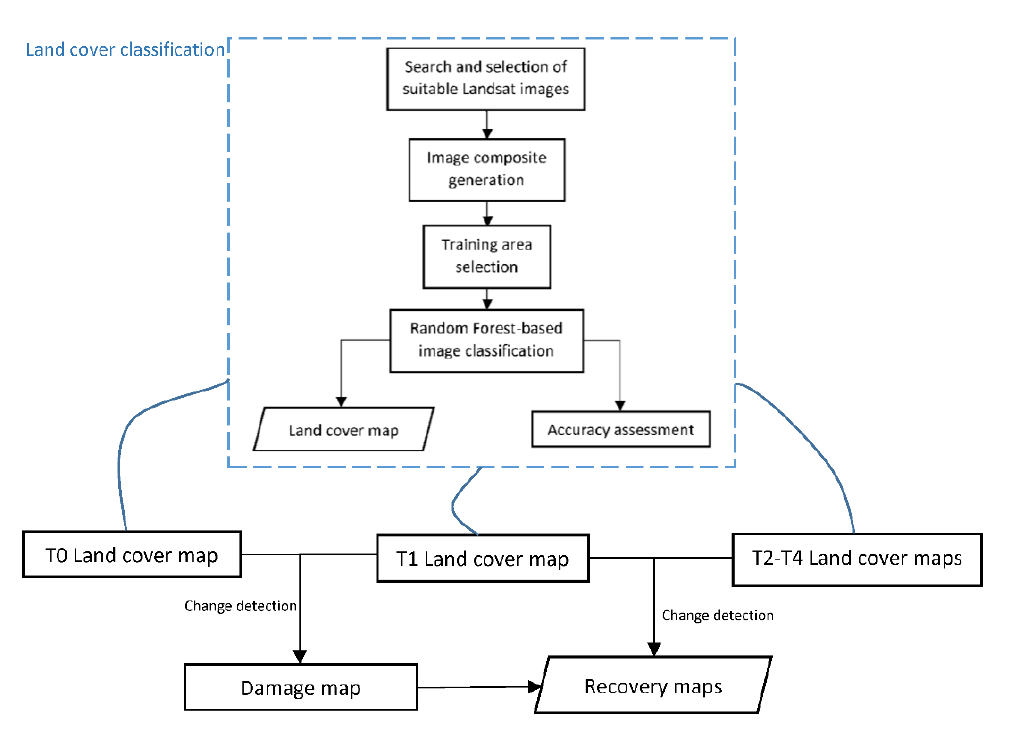
Table 2. Description of the selected land cover classes.